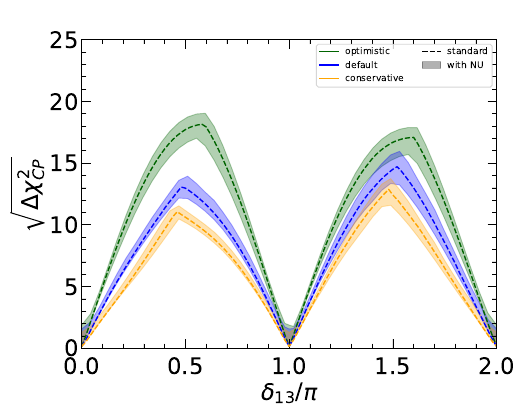
Figure 7 . The impact nonunitary neutrino mixing could have on the measurement of CP violation at ESS ν SB for different choices of systematic uncertainties. The width of the bands result from varying φ 21 in the fake data. The dashed lines correspond to the standard analyses and are the same as in figure